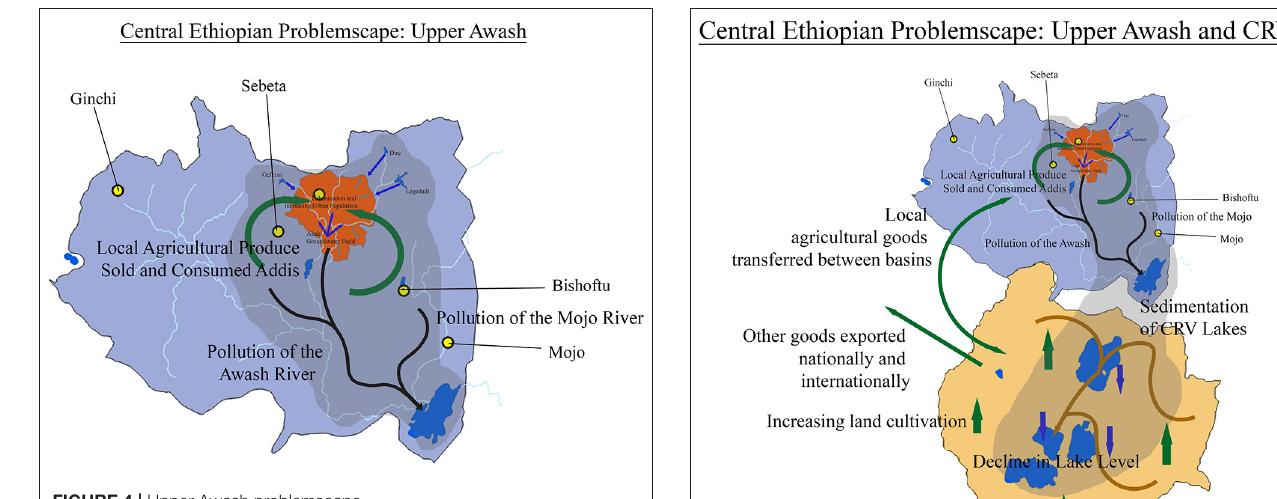
FIGURE 4 | Upper Awash problemscape.